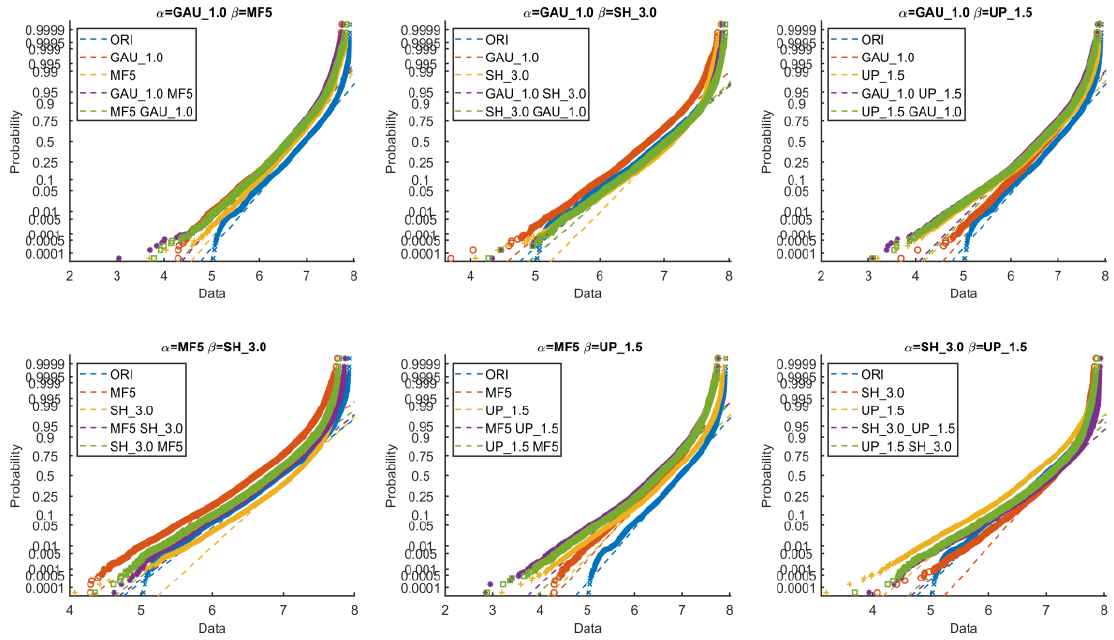
Figure 4. Normal distribution of entropy after applying operator on the image set. The proposed architecture can resist the problem of operator sequence in a better way. The CNN contains multiple layers and filters to classify the input into their respective classes. The CNN parameters like weight and biases are updated as the network learns. The image input layer is followed by seven blocks and four layers in the proposed CNN. The block diagram of the proposed CNN is shown in Figure